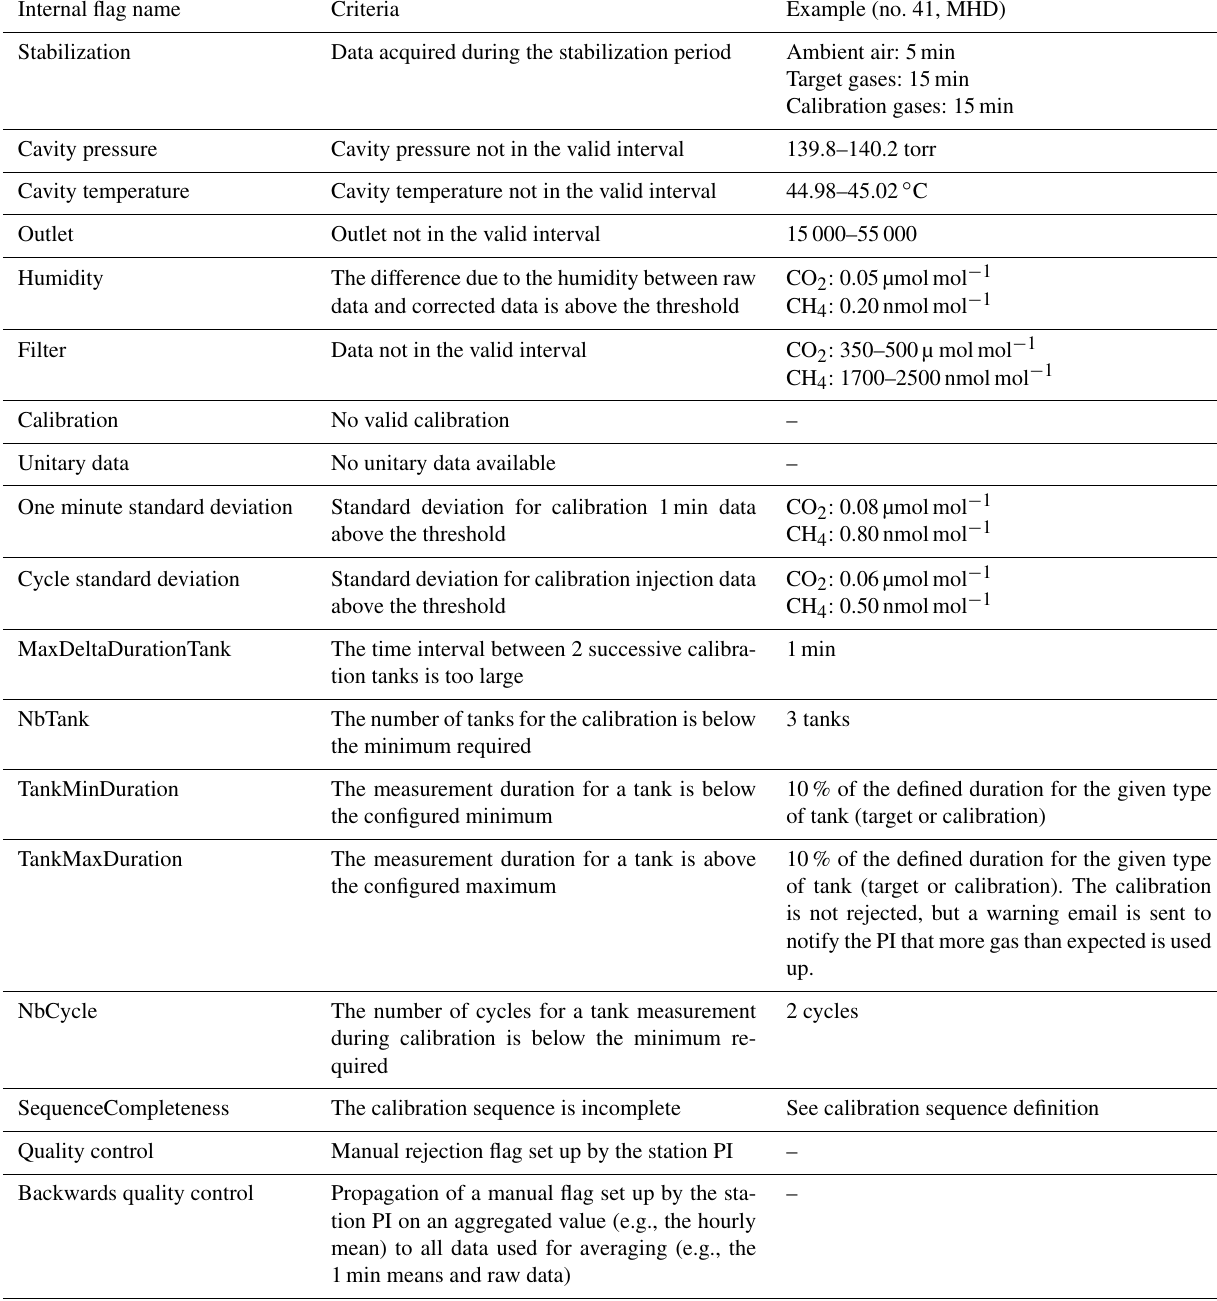
Table 5. List of internal flags for instrument type CRDS Picarro model G2301. The example provided in the third column corresponds to the configuration of instrument no. 41 at Mace Head station set up on 14 May